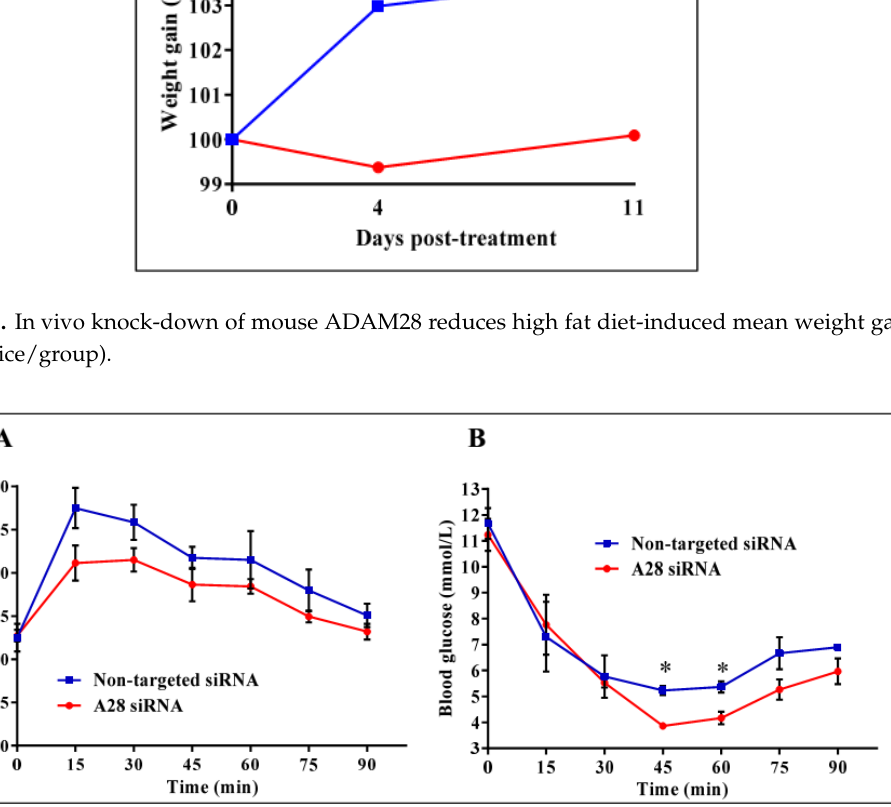
Figure 7. Metabolic testing in mice treated with ADAM28 siRNA. In vivo knock-down of ADAM28 reduces high fat diet-induced glucose intolerance ( A ), as demonstrated with glucose tolerance testing, and insulin resistance ( B ), as demonstrated with insulin tolerance testing in mice. * p < 0.05; ( n = 3 mice/group).